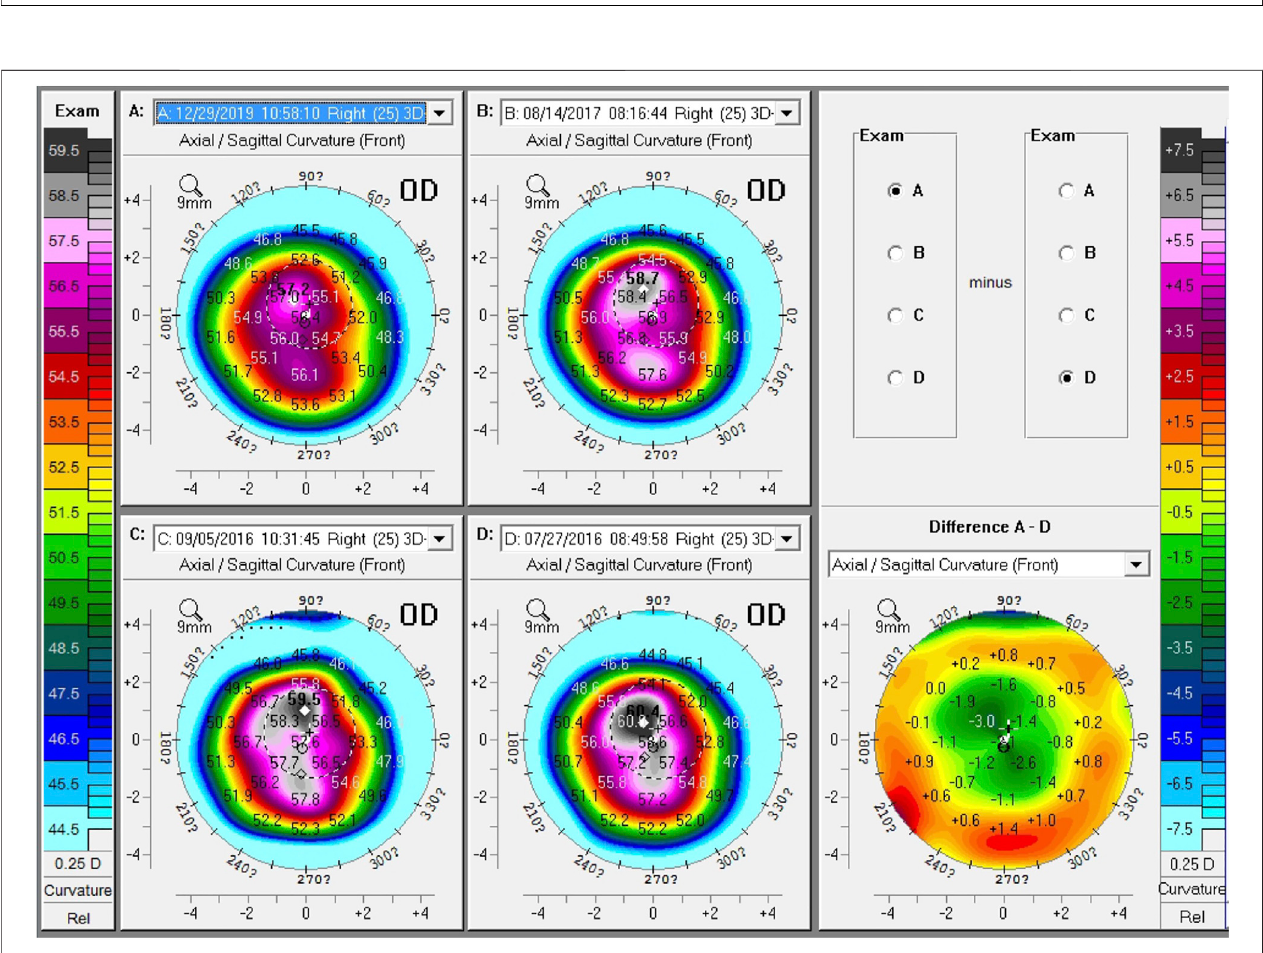
FIGURE 2| Topographic map changesof a typical case during follow-up. Comparison ofpreoperative and 41-months postoperative topographic maps, showing a 3.2 D decrease in K max , a 0.8 D decrease in K1, a 2.4 D decrease in K2, and a 1.5 D decrease in astigmatism. (A) postoperative 46-months; (B) postoperative 12- months; (C) postoperative 1-month; (D) preoperative; Difference (A – D) , comparison of the preoperative and 41-months postoperative front curvature.